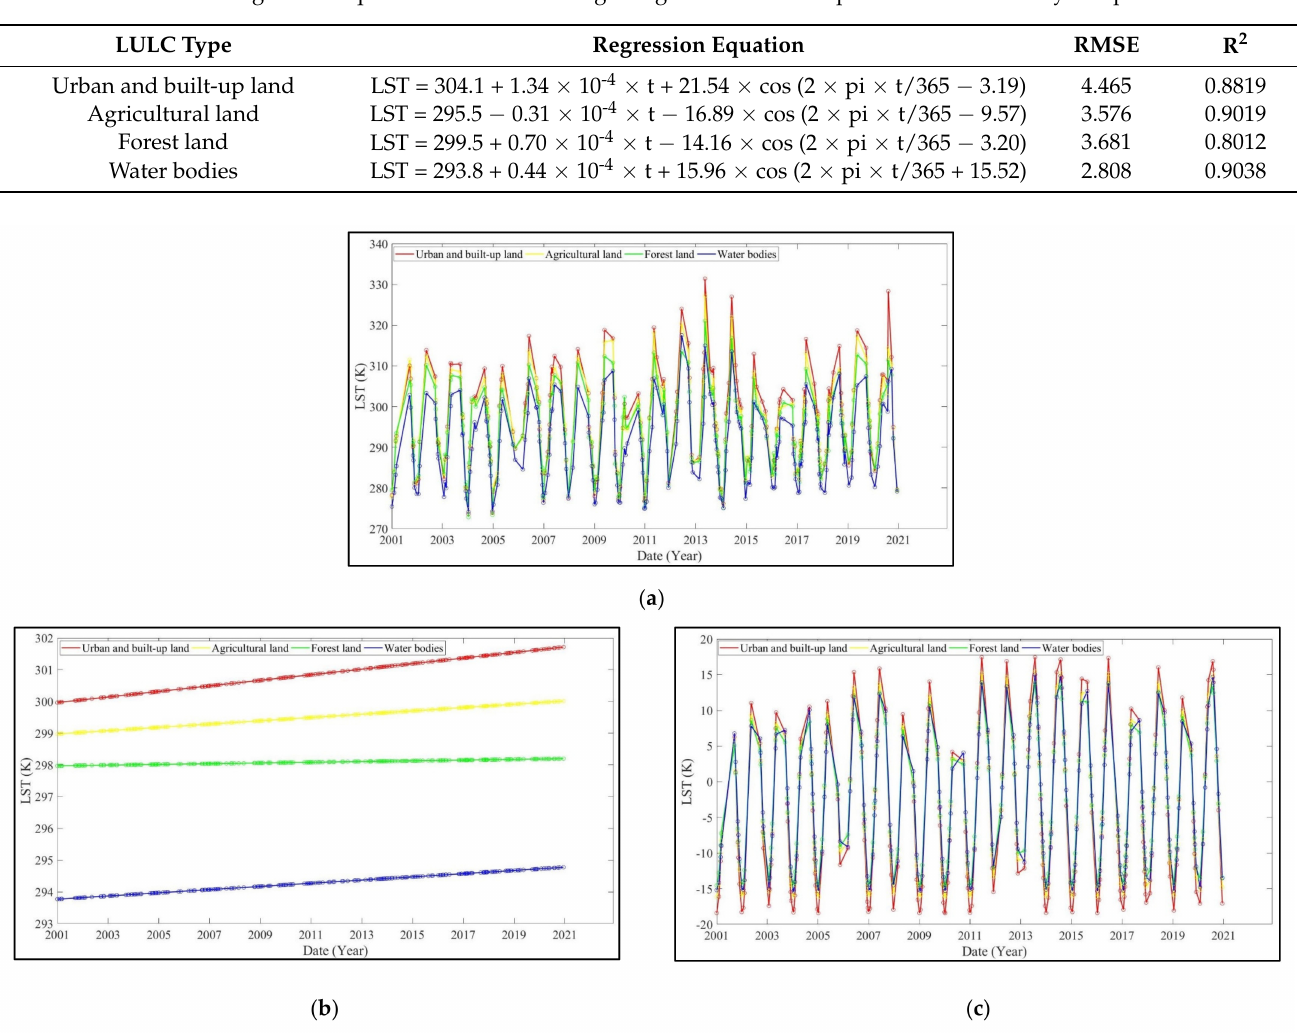
Figure 16. Mean LSTs of four different LULC types and their trend and seasonality components: ( a ) mean LSTs; ( b ) trend component of LST; and ( c ) seasonality component of